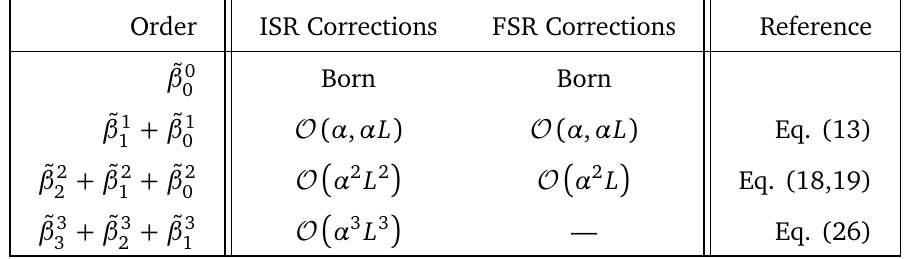
Table 2: The explicit beta terms that have been implemented in S HERPA ’s EEX. The ISR corrections are universal and are applied to any lepton-collider process. For the FSR the corrections are only applied to the f ¯ f dipoles from decays of neutral bosons. The corrections to the decay of charged bosons have been implemented in the P HOTONS module [ 44,45 ] and the two methods will be combined in future work. The reference column provides the equation number from [ 55 ] where the explicit form of the corrections are given.